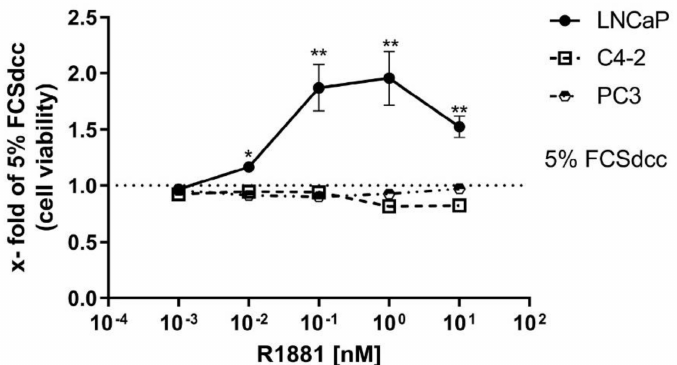
Figure 1. High R1881 concentrations inhibit the cell viability in LNCaP cells: Relative change of cell viability after 72 h of untreated and R1881 (0.01, 0.1, 1, 10 nM) treated LNCaP, C4-2, and PC3 cells. LNCaP cells show a concentration-dependent increase of cell viability, peaking between 10 − 1 (0.1) and 10 0 (1) nM after R1881 treatment. Conversely, 10 nM R1881 can inhibit the cell viability increasing effects in LNCaP cells. At 1 and 10 nM, C4-2 cells show a decrease to ~80% of the untreated condition. Cell viability does not change in PC3 cells after R1881 treatment. Values are expressed as x-fold of untreated cells and are displayed as mean ± s.e.m. ( n = 3). All differences highlighted by asterisks were statistically significant (* p ≤ 0.05, ** p ≤ 0.01).